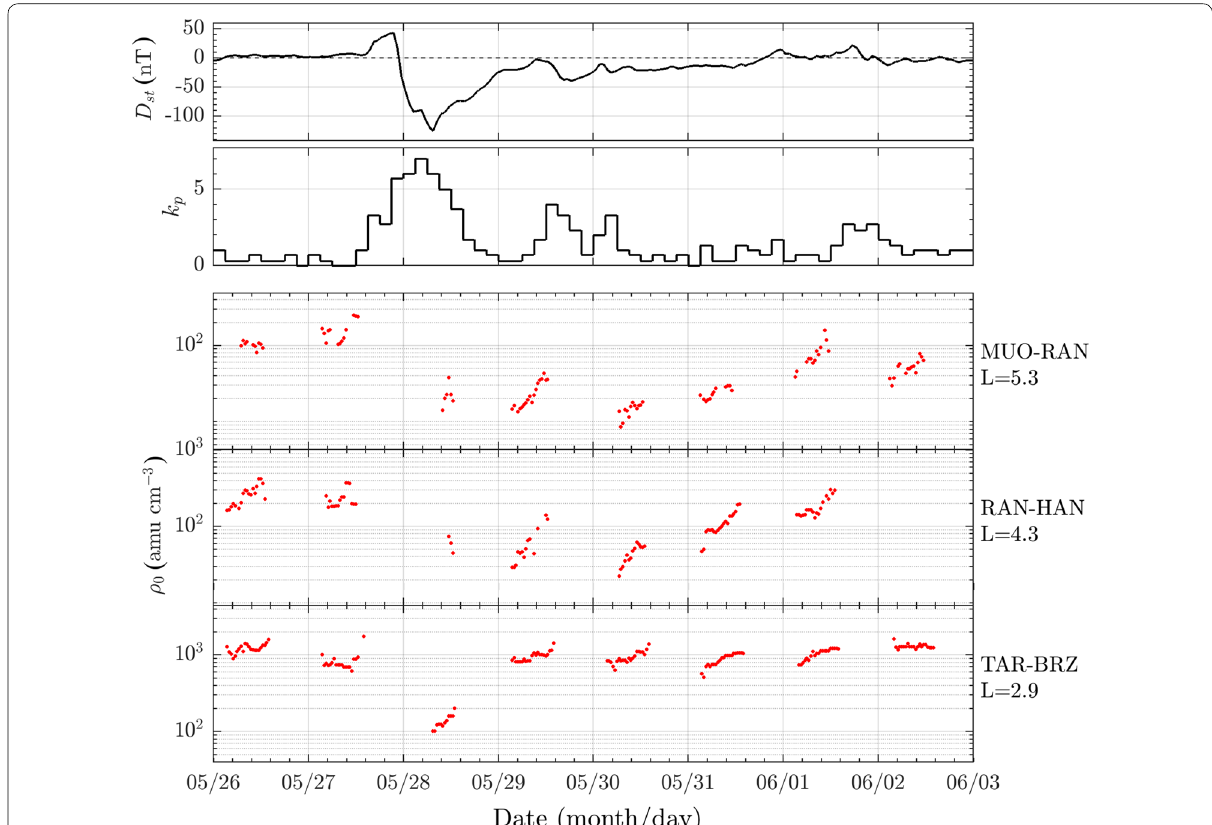
Fig. 7 From the top: the D st index, the k p index and the equatorial plasma mass density at L frequencies obtained from the three EMMA station pairs MUO–RAN, RAN–HAN and TAR–BRZ. Values are in